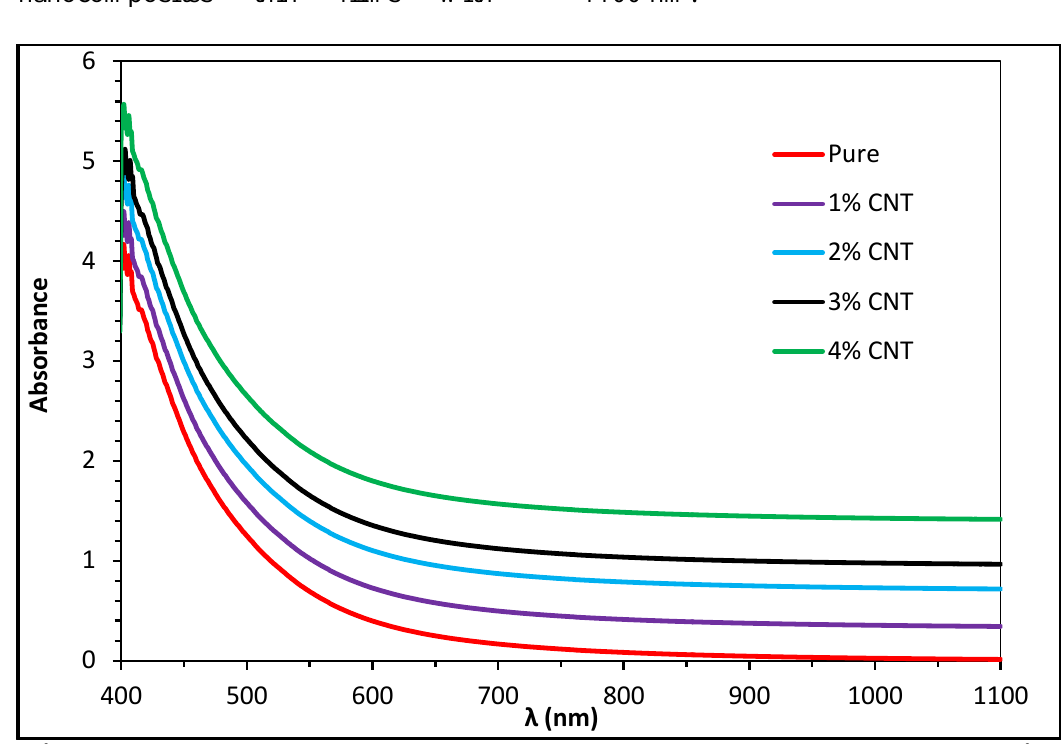
Fig. 4: The Absorbance spectra of the Pure PANI and PANI/MWCNTs nanocomposites thin films with different MWCNTs Wight concentration 1, 2, 3, 4